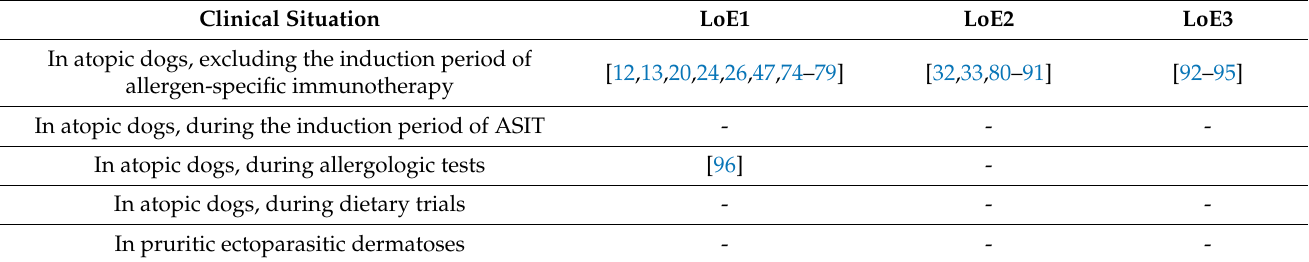
Table 5. Level of evidence (LoE) of individual studies on the use of systemic ciclosporin in different clinical